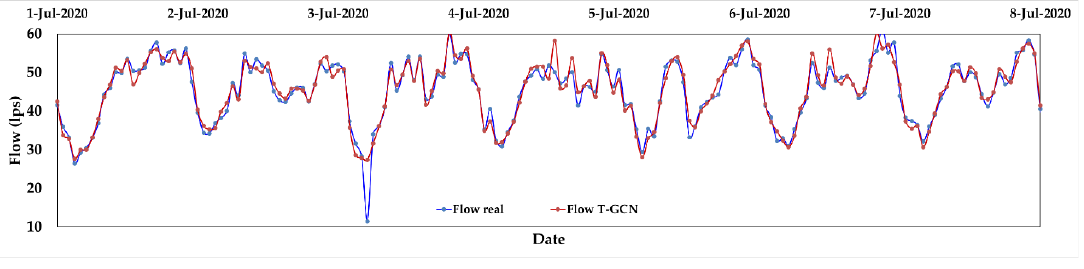
Figure 8. Comparison between estimated pressure based on real and estimated relative pump speed.